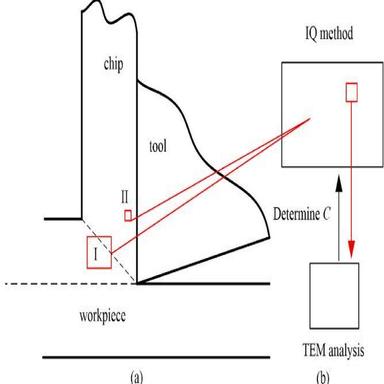
Method for obtaining the stored energy field in the cutting deformation zones. (a) The selected areas for EBSD tests, in which the areas I and II indicate the typical areas of PSZ and SDZ, respectively. (b) Schematic diagram for obtaining coefficient C in Eq. (17), in which a smaller region (red frame region) was selected for TEM analysis. (For interpretation of the references to colour in this figure legend, the reader is referred to the Web version of this article.)